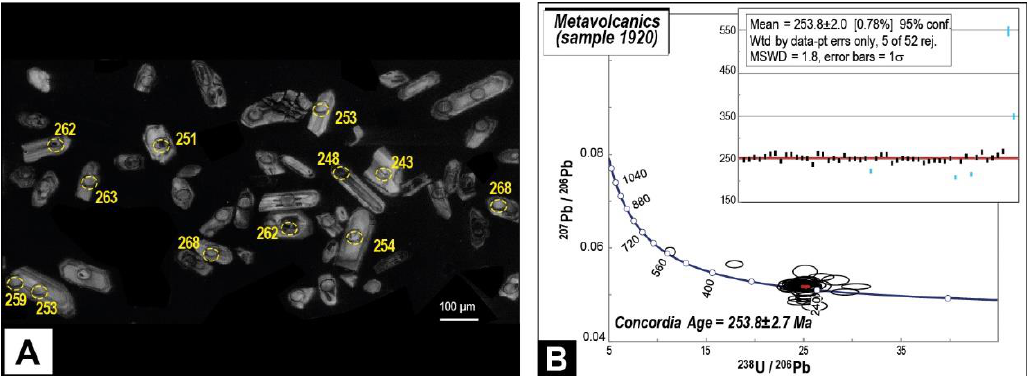
Figure 9. ( A ) CL image of some of the analyzed zircon grains (measured spots are shown by yellow circles with related ages); ( B ) concordia Tera–Wasserburg ( 207 Pb/ 206 Pb vs. 238 U/ 206 Pb) and weighted average ( 206 Pb/ 238 U ages) diagrams for analyzed zircons (sample 1920).